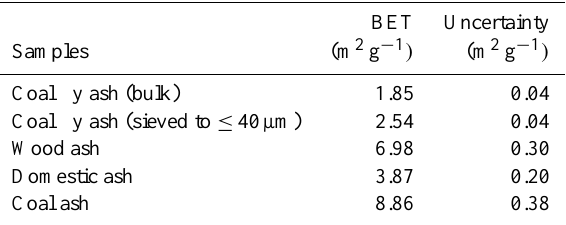
Table 1. Specific surface areas (SSA) of combustion ashes as measured by BET nitrogen gas adsorption method. All coal fly ash (CFA), wood, domestic and coal bottom ashes were sieved to ≤ 40µm before the measurement except CFA (bulk). CFA (bulk) denotes a raw CFA sample as obtained from an electrostatic pre- cipitator of a coal-fired power plant. All data reported here were measured from a five-point adsorption isotherm with correlation co- efficient of ≥ 0.9975. The uncertainties in the measurements are in- dicated on a separate column.